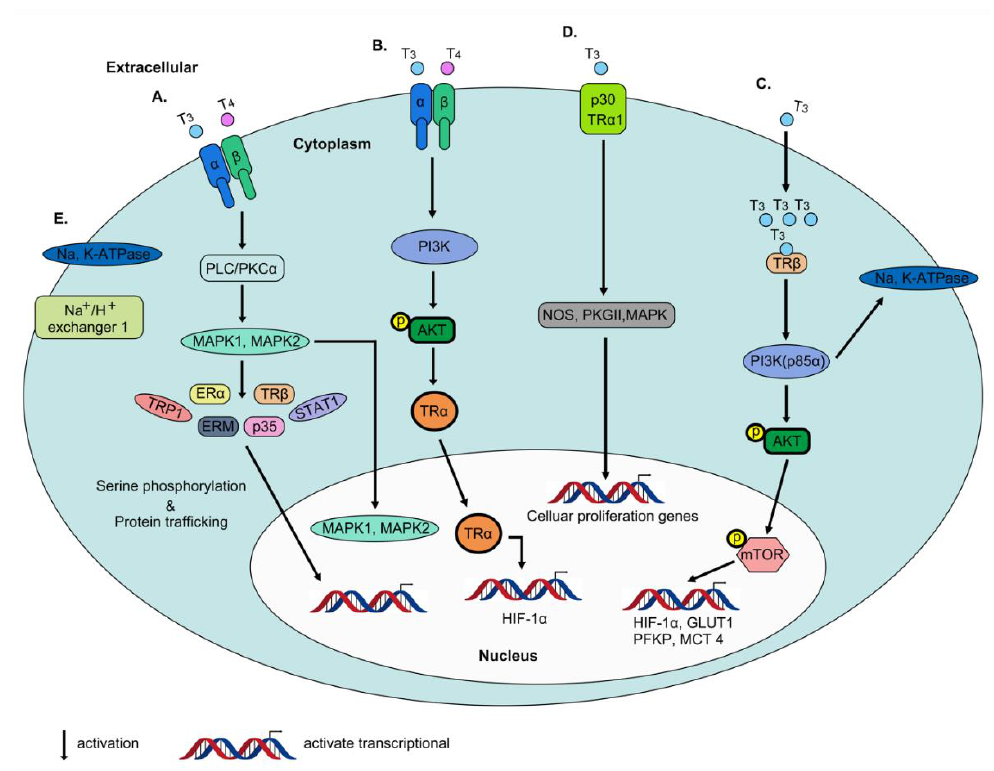
Figure 4. Non-genomic actions of thyroid hormone. THs a ff ect multiple physiological activities within the cell via interactions with integrin α v β 3. ( A ) α v β 3 that binds both T 3 and T 4 , leading to regulation of MAPK / ERK1 / 2 via PLC and PKC α , promoting phosphorylation of nucleoproteins TRP1, ERM, STAT1 and p35 and modulation of intracellular protein tra ffi cking of ER α and nuclear uptake of TR β from the cytoplasm. ( B ) α v β 3 that specifically recognizes T 3 and activates the PI3K / Akt / PKB pathway via stimulation of Src kinase, leading to direct tra ffi cking of TR α 1 from the cytoplasm to the nucleus and transcriptional activity of the target gene, HIF-1 α . ( C ) In the cytoplasm, the PI3K pathway is rapidly activated via T 3 interactions with TR β 1 and initiates downstream target gene transcription including HIF-1 α , GLUT1, PFKP and MCT 4. ( D ) At the plasma membrane, T 3 interacts with p30 TR α 1, and binding of PI3K to p85 α inactivates transcription of downstream genes. However, the T 3 -liganded TR α 1 complex activates a series of signal transduction proteins (PKGII and ERK) and NOS. ( E ) T 3 -liganded TR β 1 stimulates MAPK / ERK 1 / 2 activity, which activates the sodium proton exchanger (Na + /H + ) in the plasma membrane.